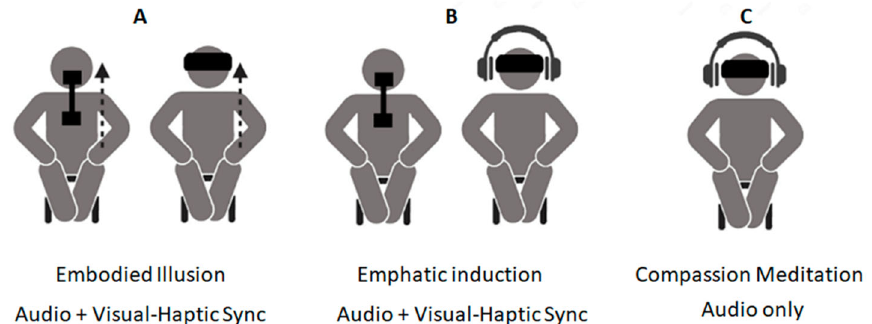
Figure 2. Phases of the virtual reality (VR) condition. ( A ) Body swap illusion phase: the participant takes over the body of the performer/person with panic disorder; ( B ) the participant listens to the story of the person with panic disorder; ( C ) the participant performs a compassion-based meditation to enhance the desire to alleviate the embodied person’s suffering.